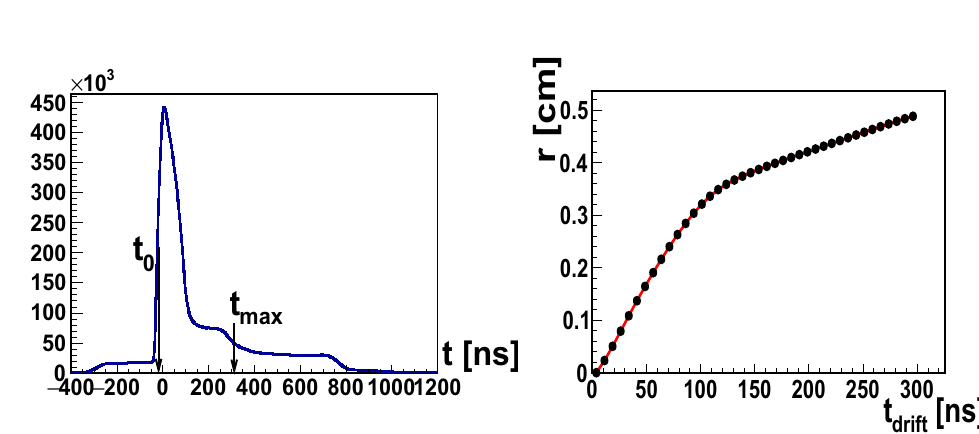
Figure 1. Drift time spectrum for the carbon beam data (on the left) and the corresponding r - t calibra- tion curve (on the right)